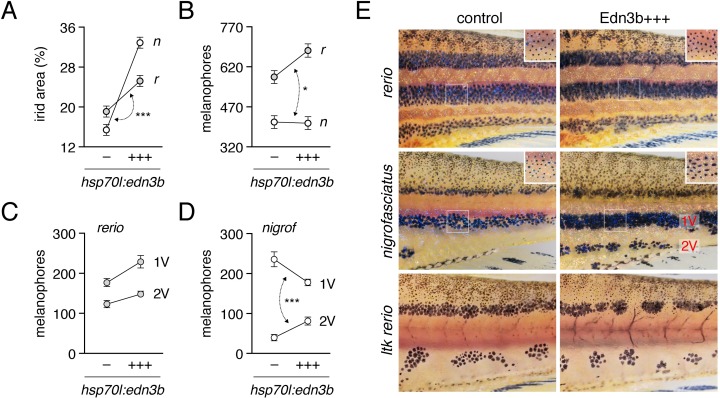
Edn3b increases iridophore coverage in both species and affects melanophore distribution indirectly in D. nigrofasciatus.(A) In both D. rerio (r) and D. nigrofasciatus (n), relative areas of the flank covered by interstripe (dense) iridophores was increased in response to Edn3b overexpression (+++) as compared to non-transgenic (–) sibling controls treated identically. The response to Edn3b overexpression was more pronounced in D. nigrofasciatus than in D. rerio (species x transgene interaction, F1,55 = 26.49, P<0.0001; double headed arrow, different slopes) (B) Edn3b overexpression increased total numbers of hypodermal melanophores in D. rerio but not D. nigrofasciatus (species x transgene interaction, F1,55 = 4.7, P<0.05). (C,D) Distributions of melanophores in ventral primary (1V) and ventral secondary (2V) stripes of D. rerio (C) and D. nigrofasciatus. In D. nigrofasciatus, Edn3b overexpression did not increase the total numbers of melanophores in these stripes (F1,28 = 0.4, P = 0.5) but did result in a reallocation of melanophores from 1V to 2V (paired comparison within individuals, stripe position x transgene interaction (F1,26 = 71.0, P<0.0001). All plots show means±SE. (E) Top and middle panels, Phenotypes of each species with and without Edn3b overexpression. In addition to changes in iridophore coverage and melanophore distribution, melanophores of D. nigrofasciatus overexpressing Edn3b tended to have more dispersed melanin than melanophores of D. nigrofasciatus controls. Insets show details of 1V stripes following epinephrine treatment, which contracts melanin granules to cell centers and more clearly reveals individual melanophores. All melanophore counts were performed on images of epinephrine-treated fish. Lower panels, Iridophore-free ltk mutant D. rerio in which Edn3b overexpression did not affect the numbers of melanophores (F1,27 = 1.5, P = 0.2) or their allocation between regions (paired comparison within individuals, stripe position x transgene interaction, F1,27 = 1.5, P = 0.2). Positions of stripe breaks and spots were variable among ltk mutants and were not consistently altered depending on Edn3b overexpression. Sample sizes (N): 15 D. rerio (–); 15 D. rerio (+++); 15 D. nigrofasciatus (–); 15 D. nigrofasciatus (+++); 15 ltk mutant D. rerio (–); 15 ltk mutant D. rerio (+++).